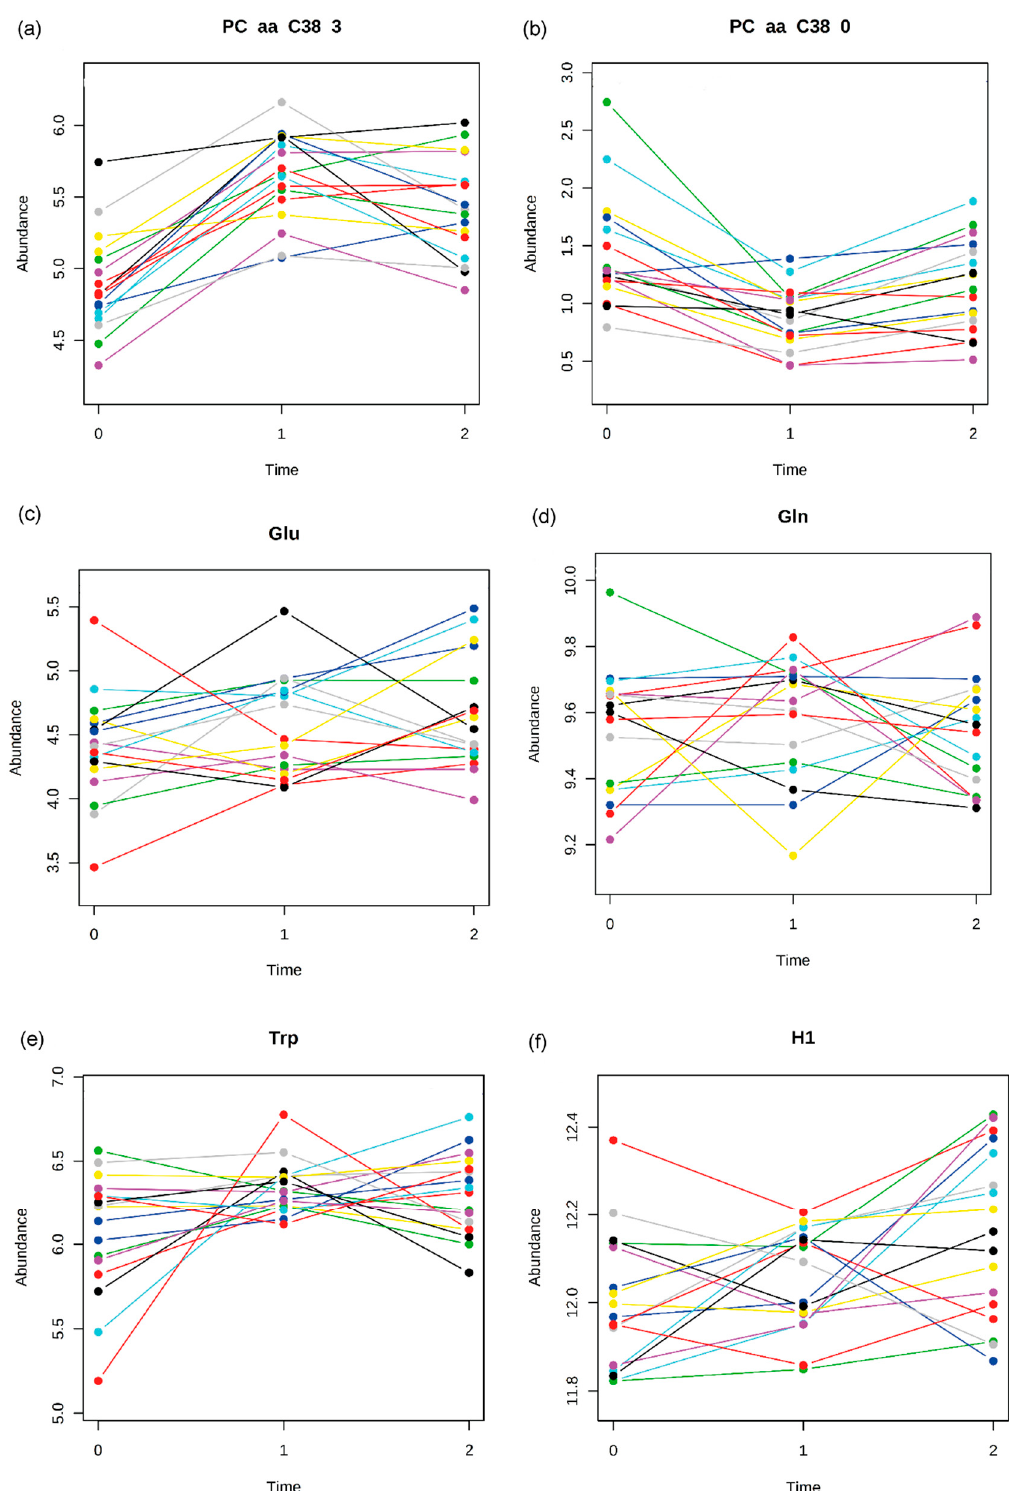
Figure 3. Individual time course profiles of metabolites. Illustration of selected time course profiles (N = 17) of metabolites in T 0 (0), T 1 (1) and T 2 (2) showing either homogenous or heterogeneous patterns. Each line represents the time course profile for one individual patient: ( a ) PC aa C38:3: Phosphatidylcholine (highest Hotelling’s T 2 in MEBA), ( b ) PC aa C38:0 (best fit in pattern group 2, Table 3), ( c ) Glu: Glutamic acid, ( d ) Gln: Glutamine ( e ) Trp: Tryptophan, ( f ) H1: sum of hexoses (including glucose).